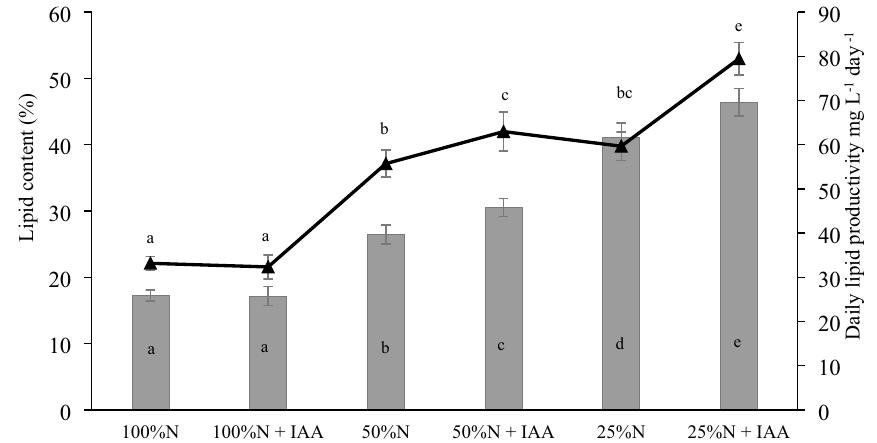
Figure 3. Impact of culture conditions on lipid content (gray bars) and daily lipid productivity (black triangles) in Eustigmatos calaminaris . Data are expressed as means (± SD), n = 9. Means followed by the same letter are not significantly different; Tukey HSD test, p < 0.05.